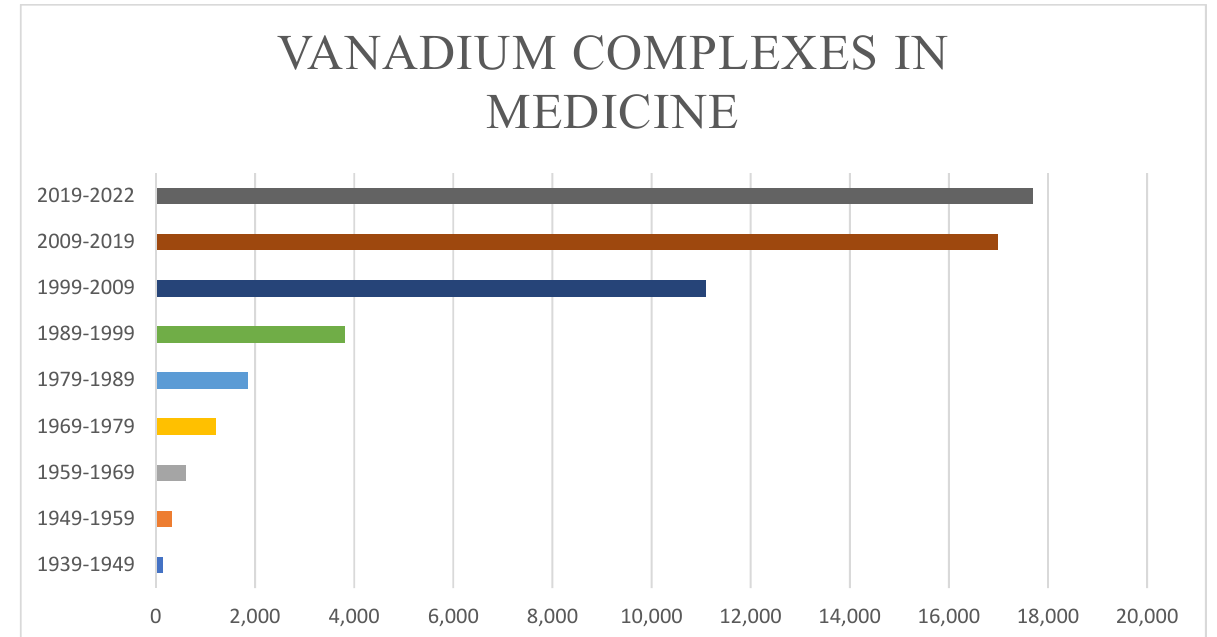
Figure 1. Published studies using vanadium complexes in medical applications. Studies were found by searching the exact phrase “vanadium complexes in medicine” on Google Scholar (http://scholar.google.com (accessed on 22 March 2022)).